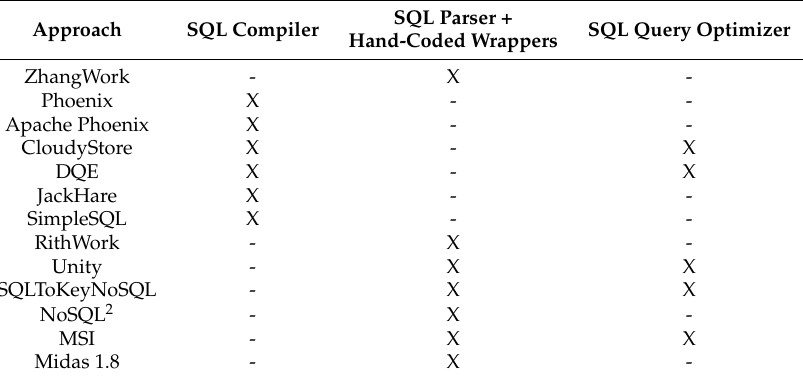
Table 5. Comparison of SQL operation mapping